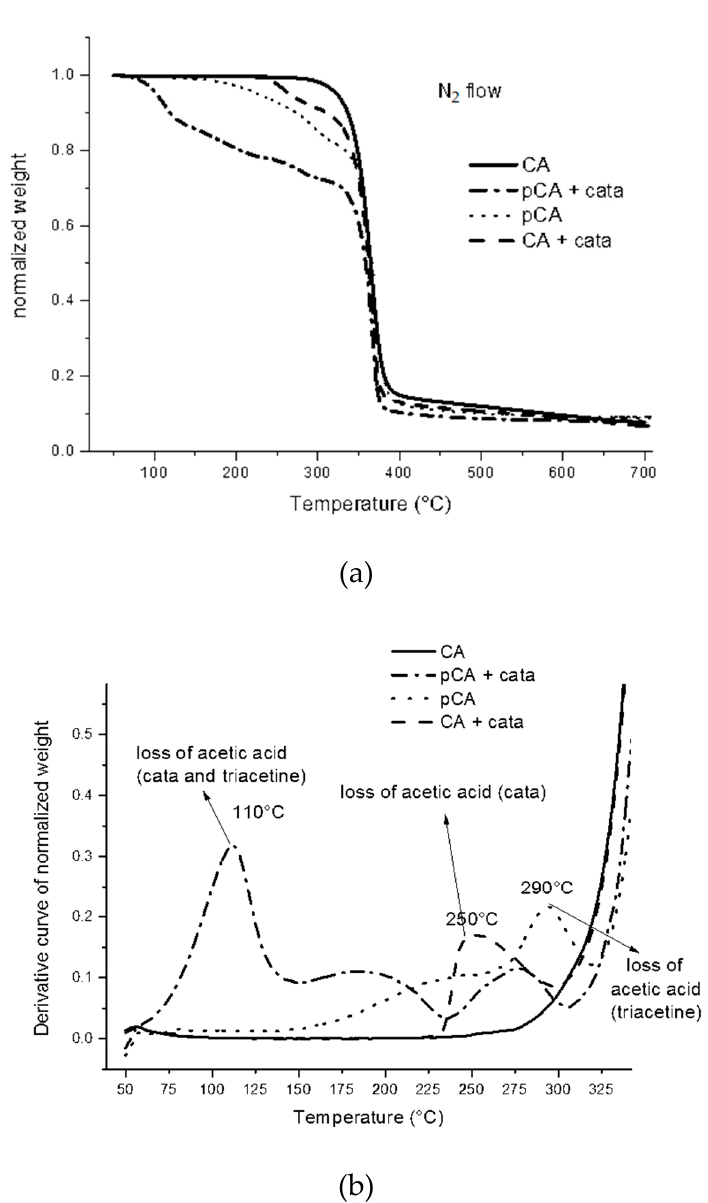
Figure 4. Thermogravimetry experiments on CA samples: ( a ) mass loss as a function of temperature; ( b ) enlargement in the 50–325 °C range of the derivative curve to show mass loss inflection points.